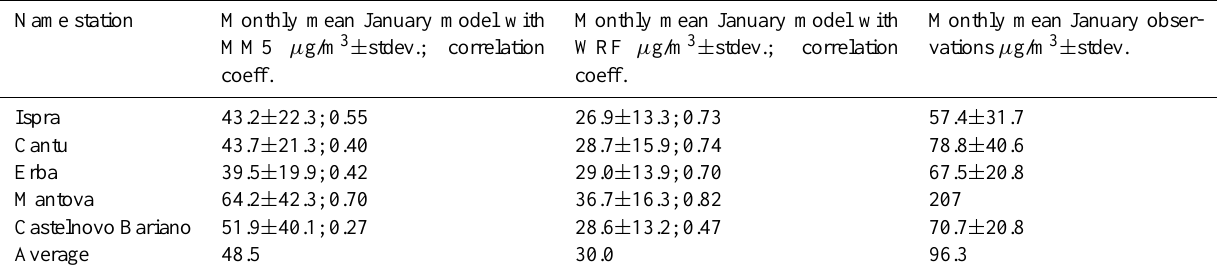
Table 4. Monthly mean PM 10 concentrations calculated by the CHIMERE model using MM5 and WRF meteorology for January 2005, including the standard deviation and the temporal correlation coefficient, together with the measurements.